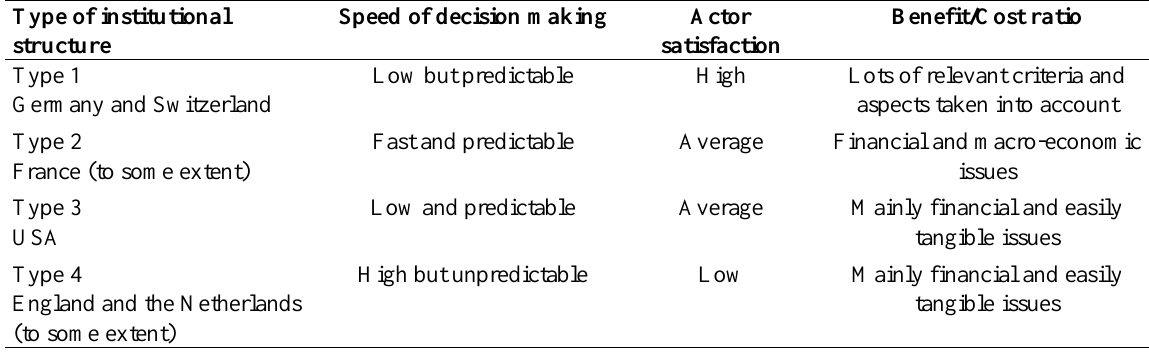
Table 3a. Types of institutional structures and process performance